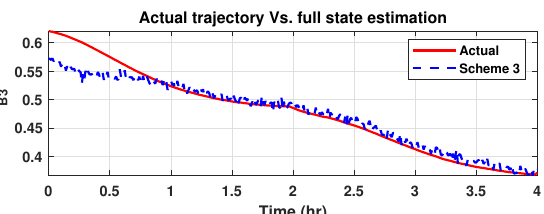
Figure 8. Trajectories of the actual states X B 3 and the estimated target variable using the full-order estimation in Scheme 3.